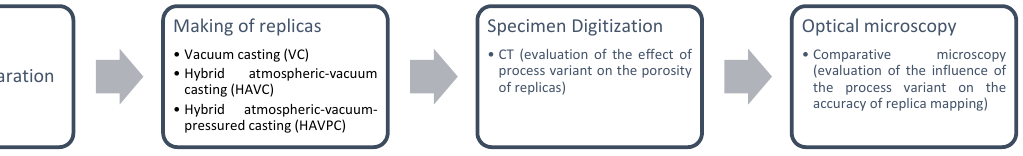
Figure 4. Schematic diagram of the tests in stage 2.